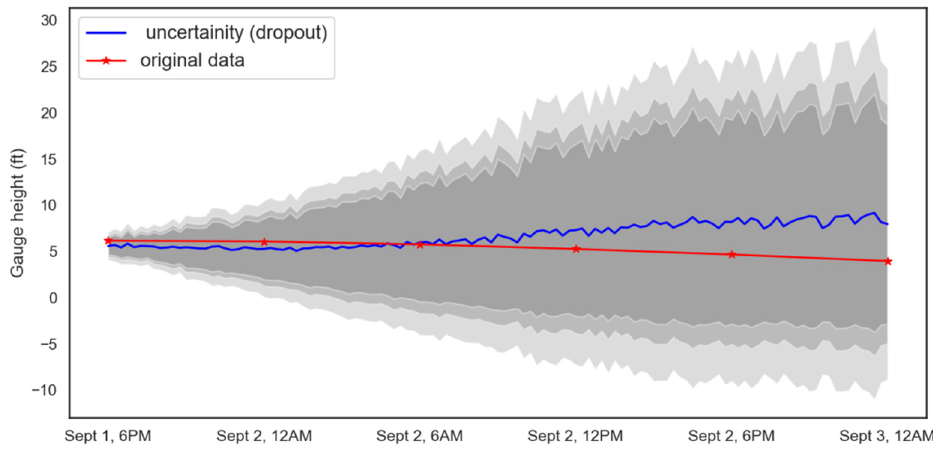
Figure 7. Out of sample prediction uncertainty estimation with “dropout.”